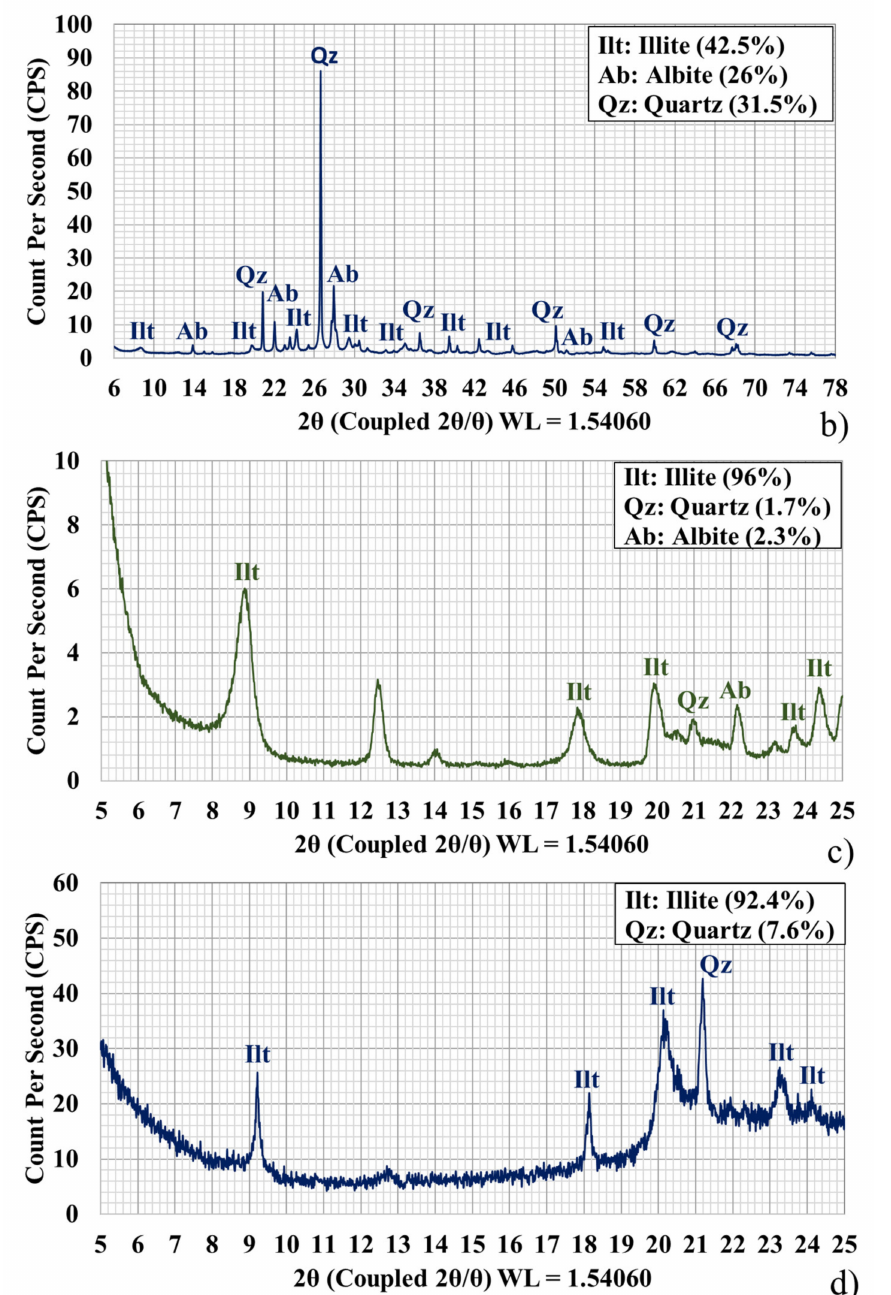
Figure 3. Whole-rock XRD pattern for ( a ) S08 and ( b ) S06. Low-angle XRD pattern for ( c ) S08 and ( d ) S06; their semi-quantitative abundance percentages computed with the DIFFRAC.EVA software are shown in